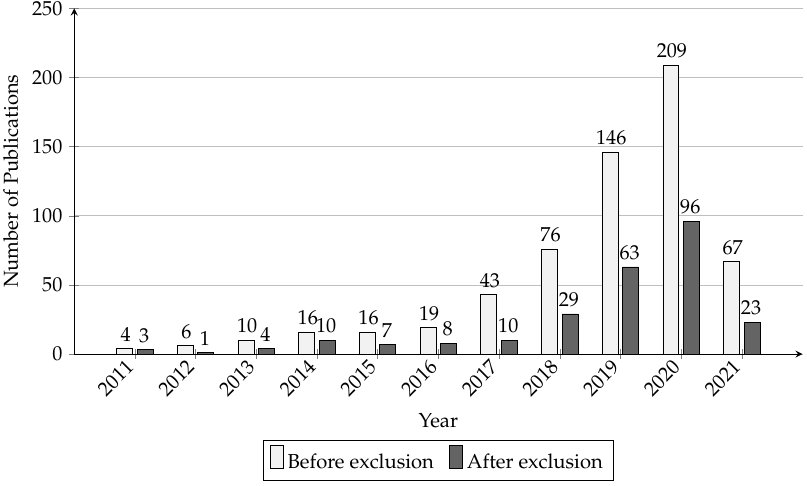
Figure 5. Number of publications over time (before and after